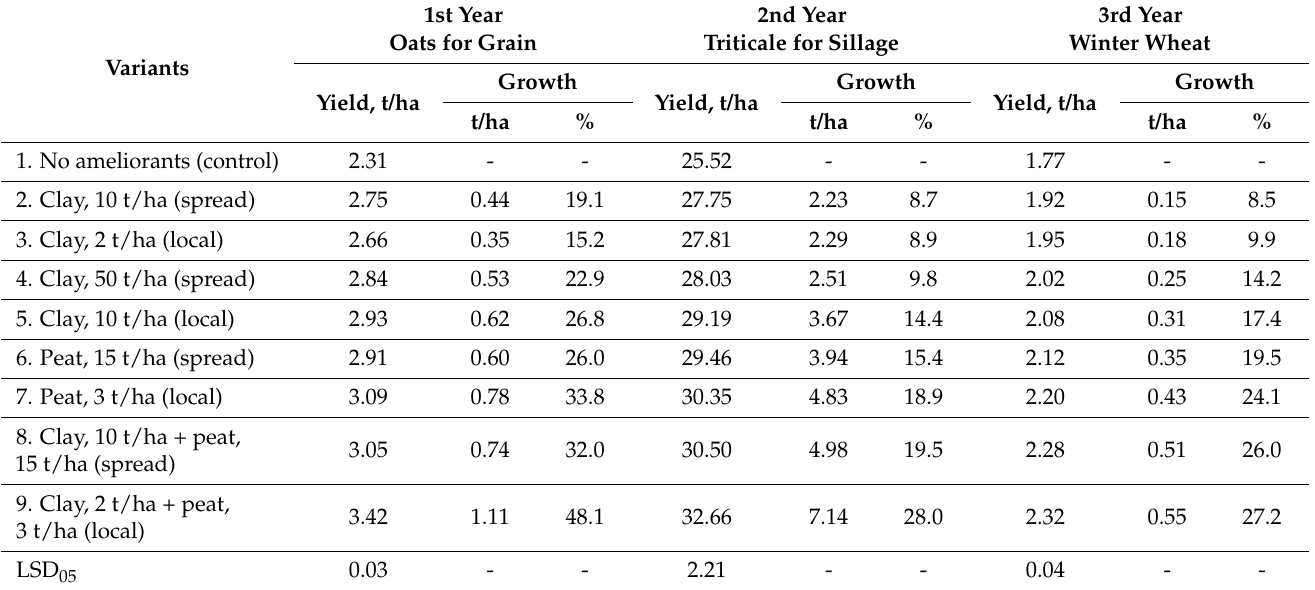
Table 5. The influence of structural ameliorants on the yield of agricultural crops in sod-podzolic cohesive sandy soil (field